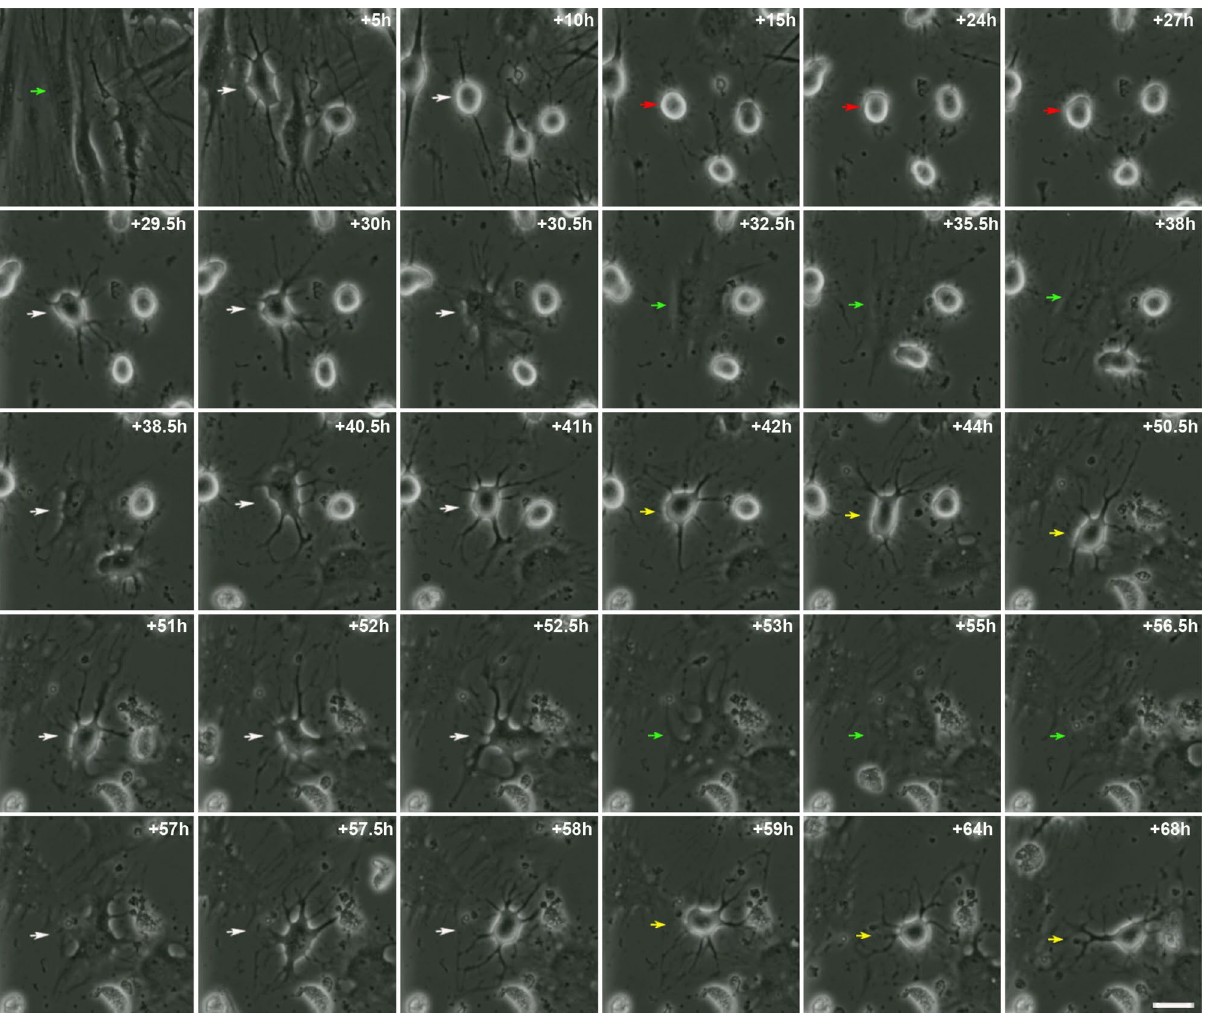
Figure 3. hBMSCs can repeatedly switch lineages. Time-lapse imaging showed that hBM-MSCs can also rapidly switch lineages without cell division. Mesenchymal morphology (green arrows); switching lineages (white arrows); intermediate morphology (red arrows); neural-like morphology (yellow arrows). Scale bar: 25